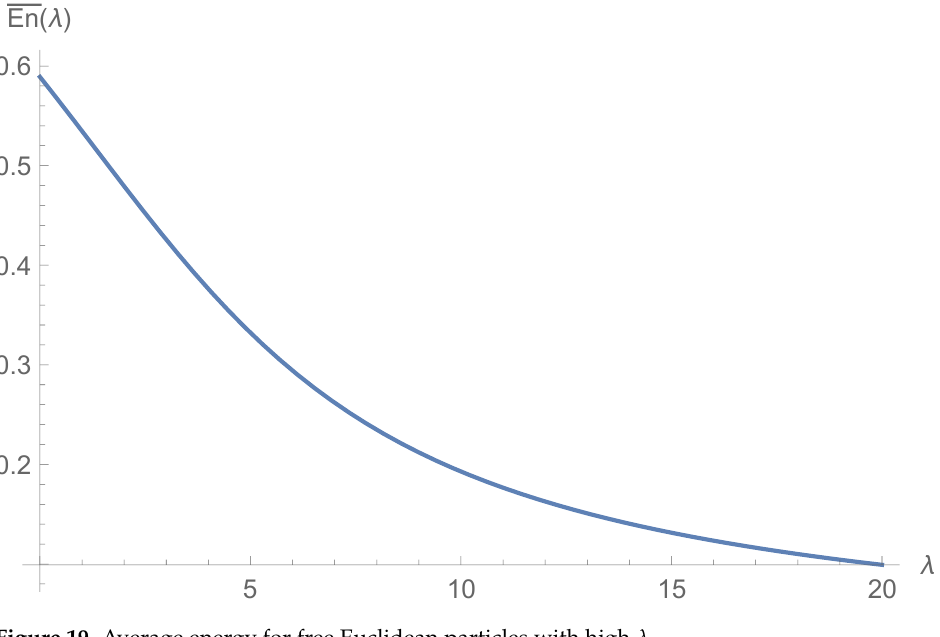
Figure 19. Average energy for free Euclidean particles with high λ